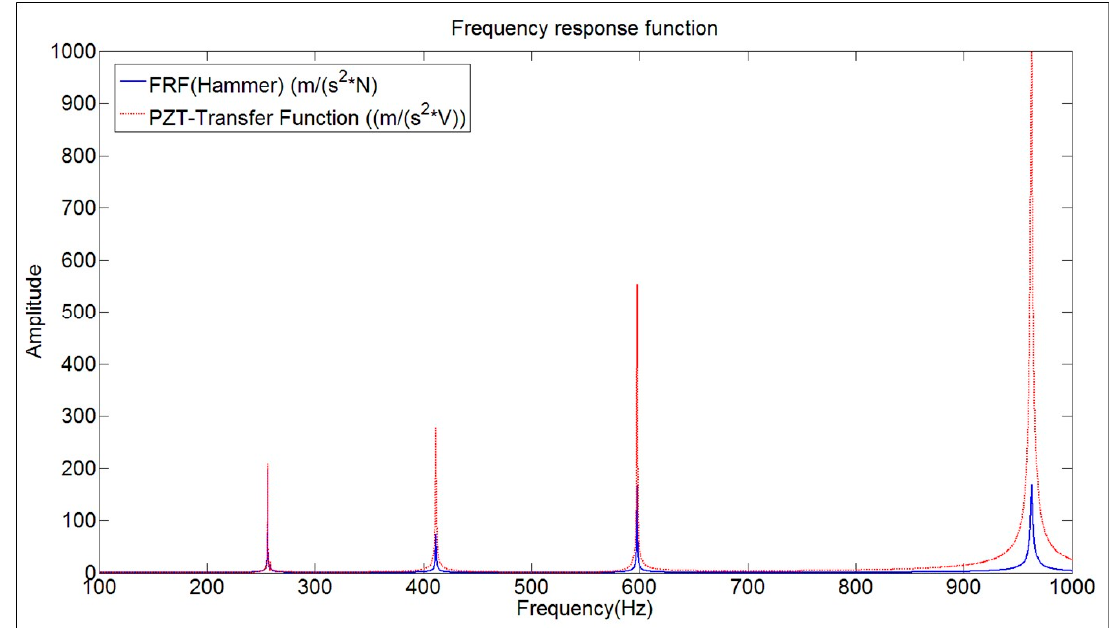
Figure 7. Comparison of the FRF obtained with the Hammer and the transfer function ((m/s 2 )/V) obtained with the PZT (chirp excitation).